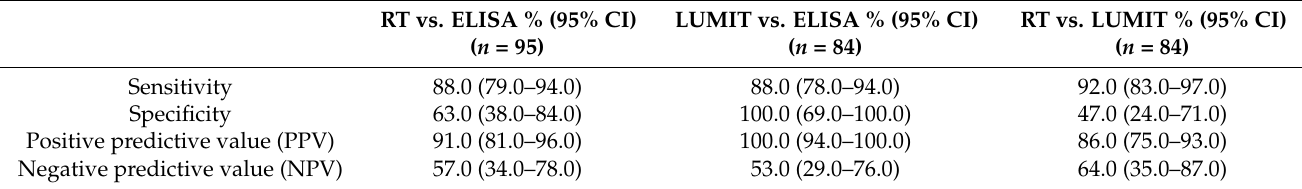
Table 4. Diagnostic performance of three immunoassays for detecting antibodies against SARS-CoV-2 according to RT-PCR positive